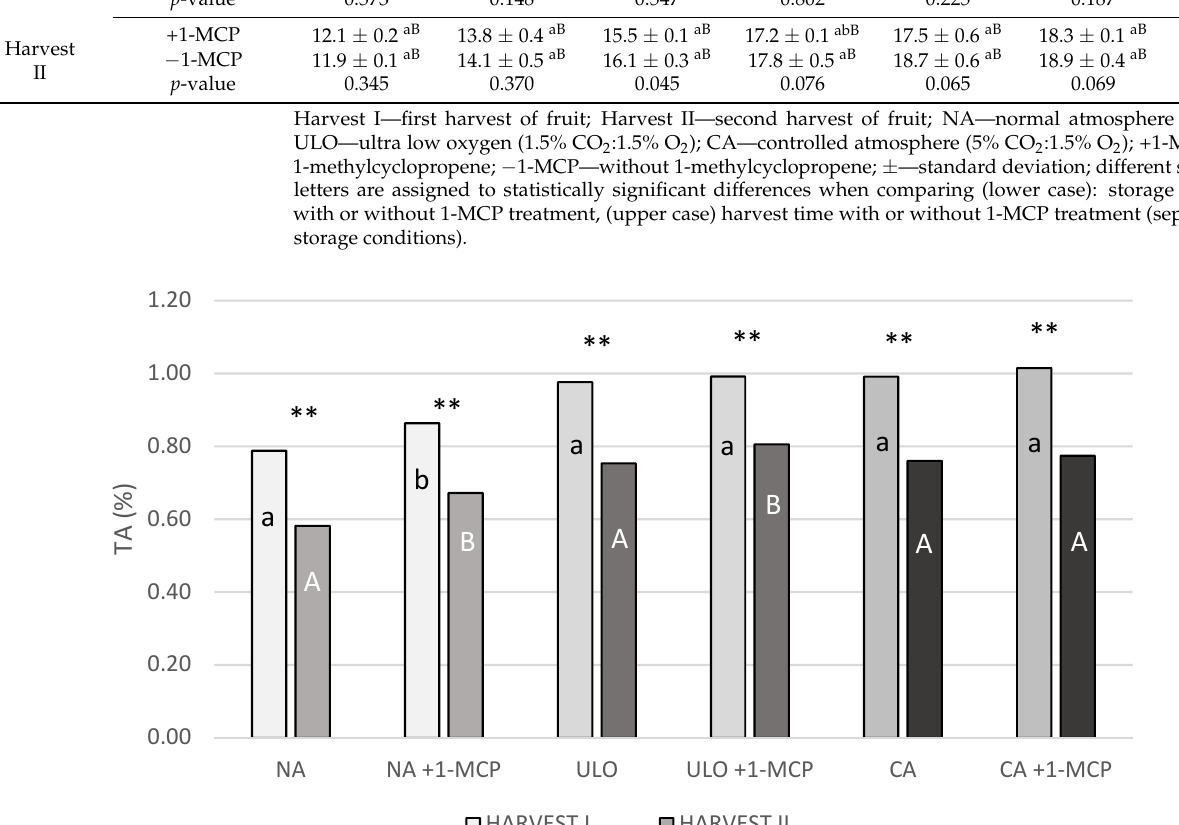
Figure 6. Titratable acidity of ‘Ananasnaya’ fruit (%) depending on harvest time and 1-MCP treat- ment under three storage technologies. Statistically significant difference between first and second harvest fruit (Newman–Keuls range test): *—for 5%. **—for 1%. Different letters were assigned to statistically significant differences when comparing the effect of 1-MCP, separately for storage con- ditions. Table 6. Changes of titratable acidity (%) measured in ‘Geneva’ mini kiwi fruit in the post-harvest period. Harvest Time